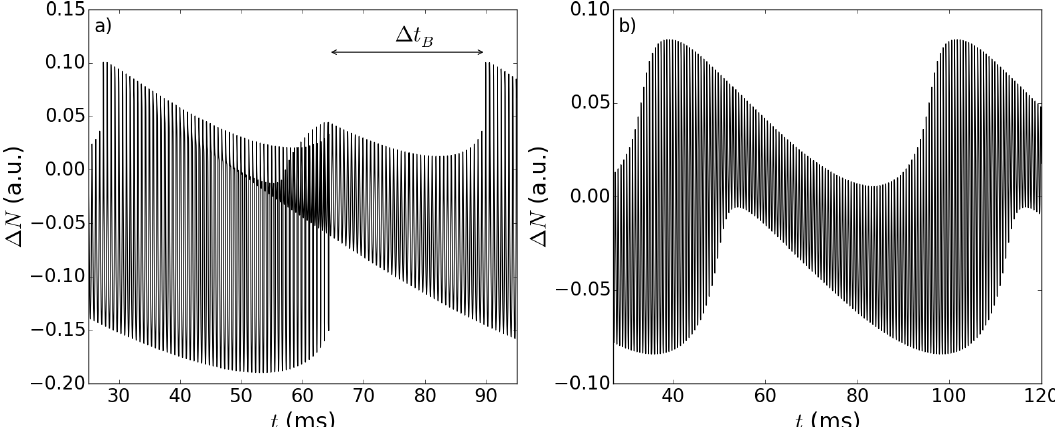
/k . The other r o = 0 . 0180 and k = 0 . 01575 . r o = 0 . 0080 r